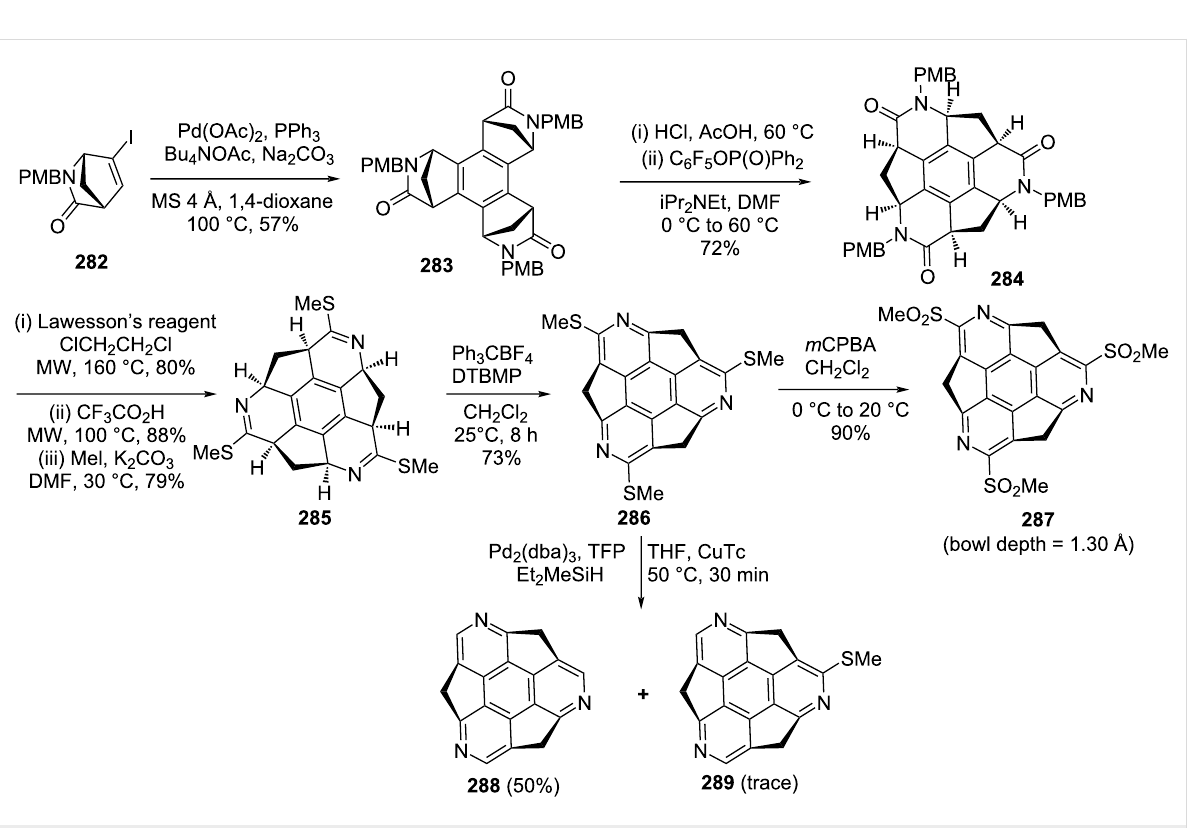
Scheme 63: Synthesis of triazasumanenes 288 and its sulfone congener 287